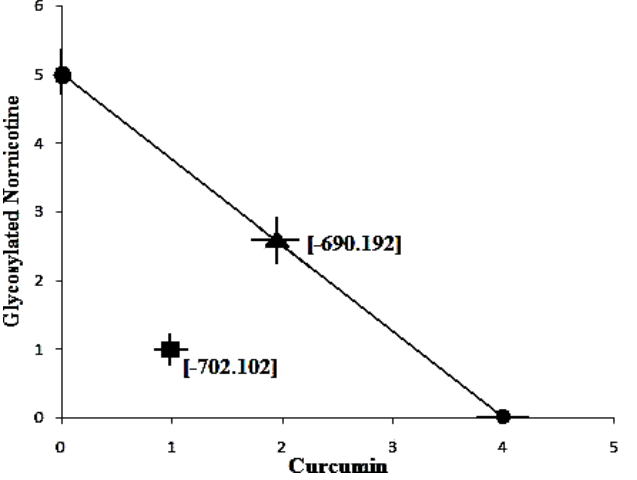
Figure 8. Isobologram showing the interaction between Curcumin and Glyconornicotine on the energetic response of Molecular Mechanics simulations. The number of molecules (for an energy minimized stable structure) of Curcumin and Glyconornicotine are contrived. The profile connecting the minimum energy points is the theoretical additive line, and the theoretical additive point (▲) for the NE combination is shown on the additive line. The minimized energy value (■) of the combination of the two NEs was significantly lower than the theoretical additive value, indicating a synergistic interaction.